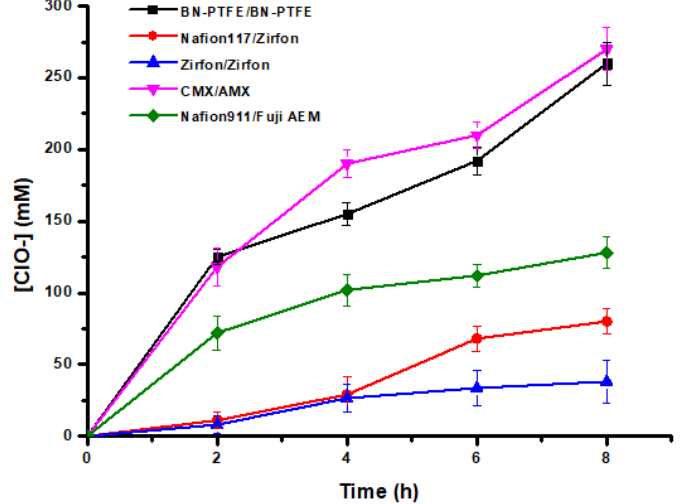
Figure 8. Kinetic curves of hypochlorite ion generation by electrolysis of brine using various types of membranes at (constant rate, room temperature, J = 16.6 mA.cm − 2 , 4.5 < pH Anodic < 5.5).